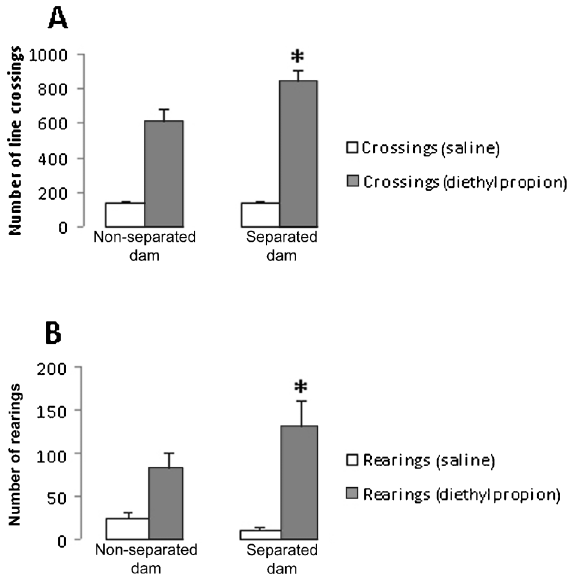
Figure 4. Behavioral profile in response to an intraperitoneal psychostimulant injection (10 mg/kg diethylpropion). Data are reported as means ± SE. A , Number of crossings was increased by the drug in comparison with saline (P , 0.0001, repeated measures ANOVA, n = 8-9 dams/group), especially in separated dams (*P = 0.032 for the group x drug interaction). B , Number of rearings was also increased by the drug compared to saline (P = 0.001) without interaction between drug and group (P .